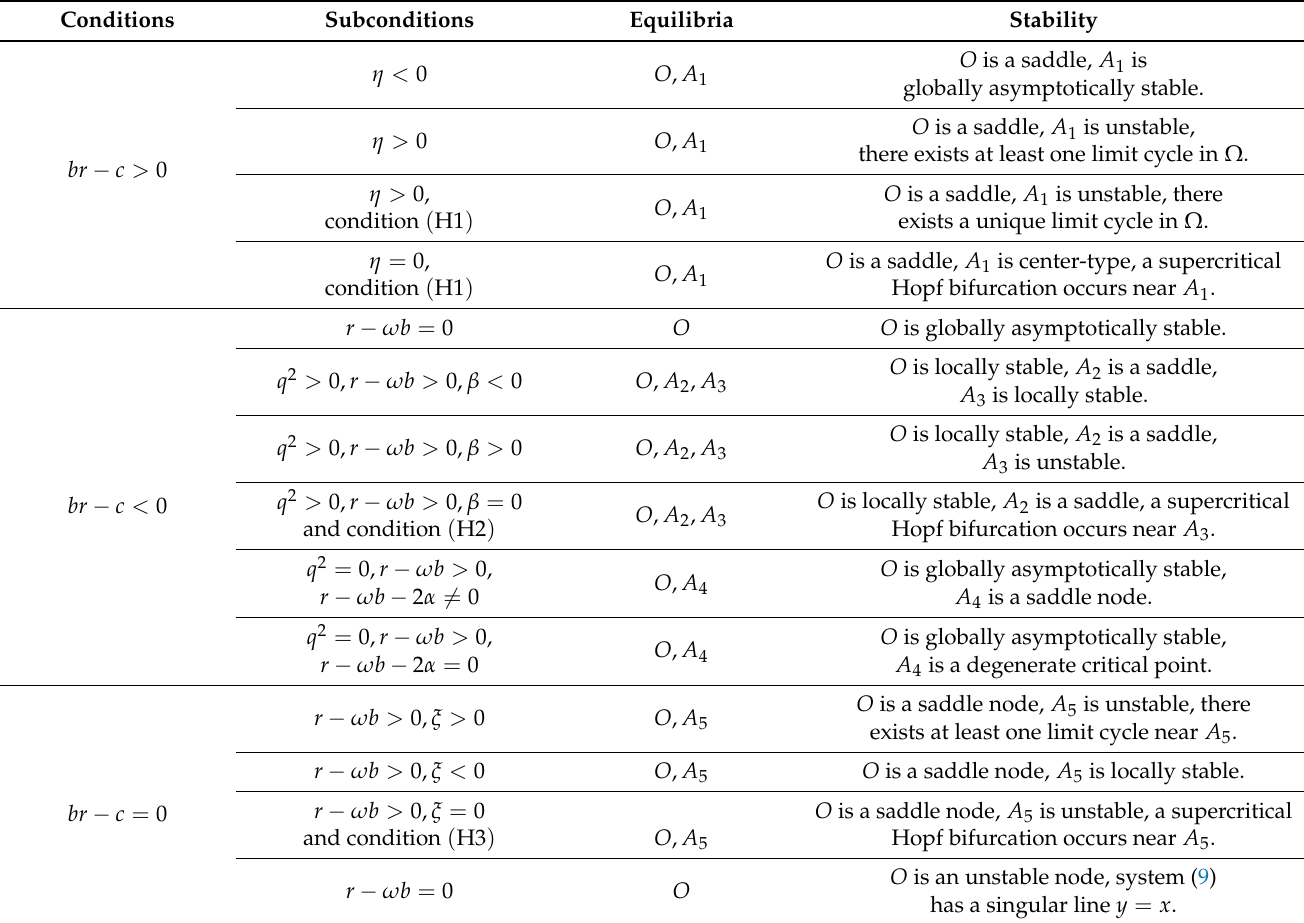
Table 1. The results under different